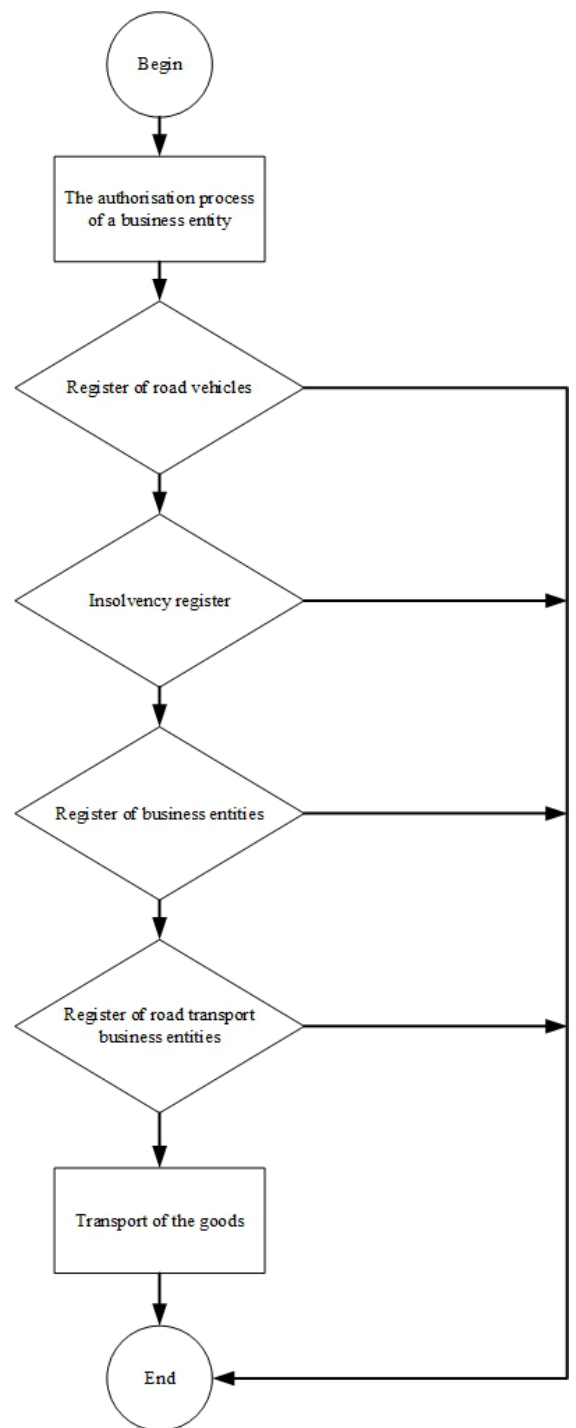
Figure 1: The flowchart of